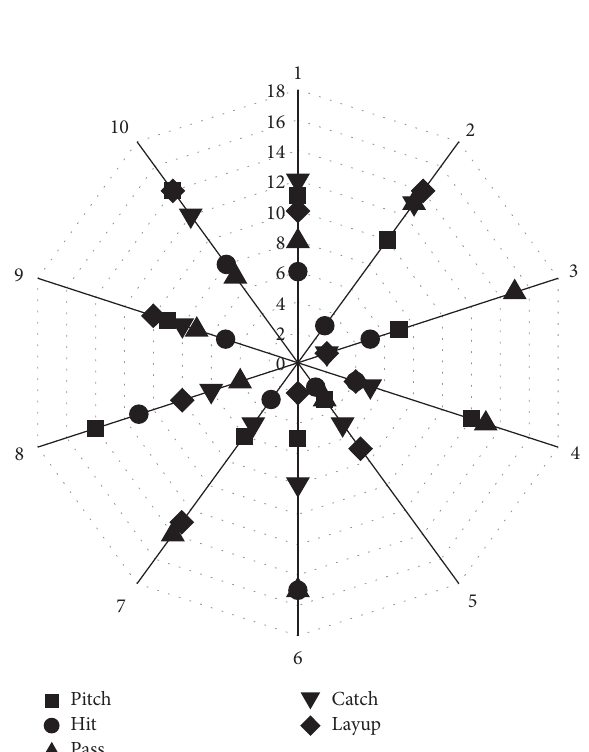
Figure 5: Deep learning model analysis results.